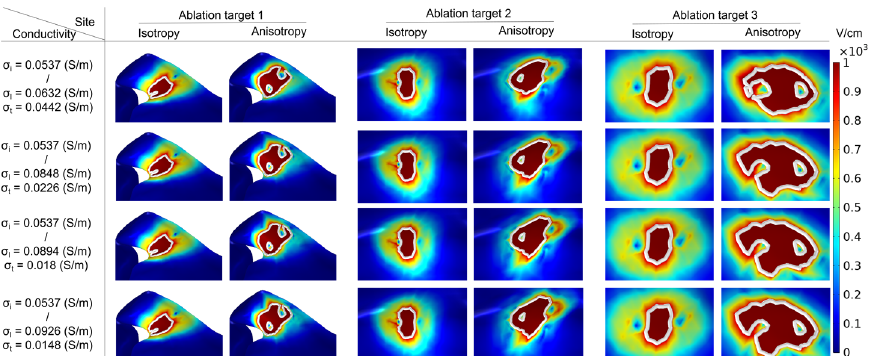
Figure 7. Under the condition of the PFA, the amplitude is 1000 V, and the electric field intensity distribution with ablation isoline is generated by different AC and IC at three ablation targets, where solid white lines represent the ablation isoline and are defined as the electric field intensity equal to 1000 V/cm.